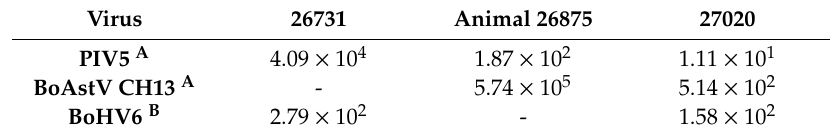
Table 2. Copy numbers of PIV5, BoAstV CH13, and BoHV6 in animals 26731, 26875, and 27020.